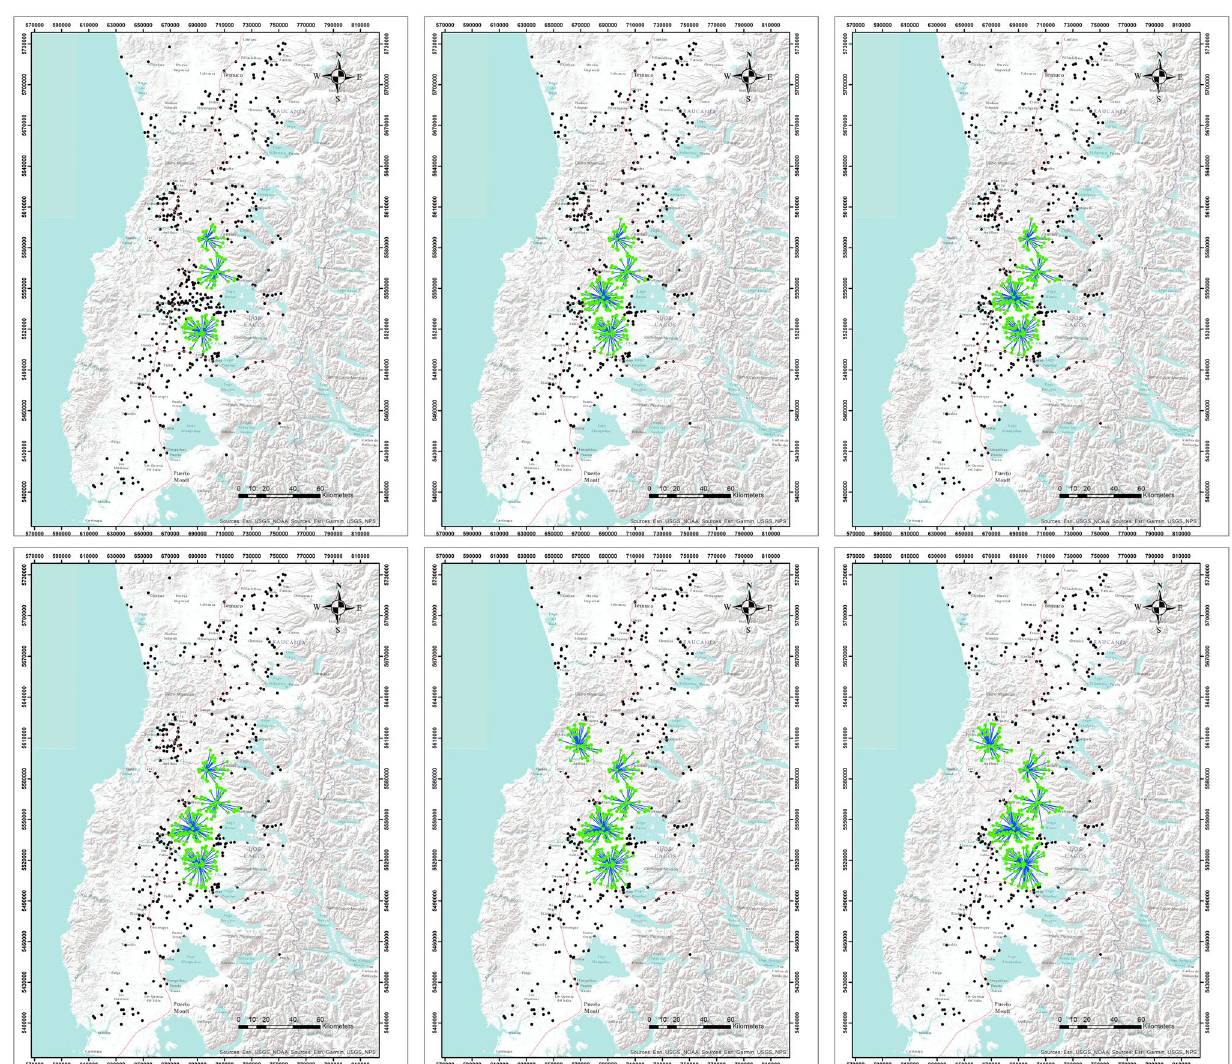
Fig. 7 Location of the configurations of the best combination found, with 50% biomass availability scenario, transport cost of 0.3 USD/tkm and energy price of 94, 96, 98, and 100 USD/MWh, in order of reading